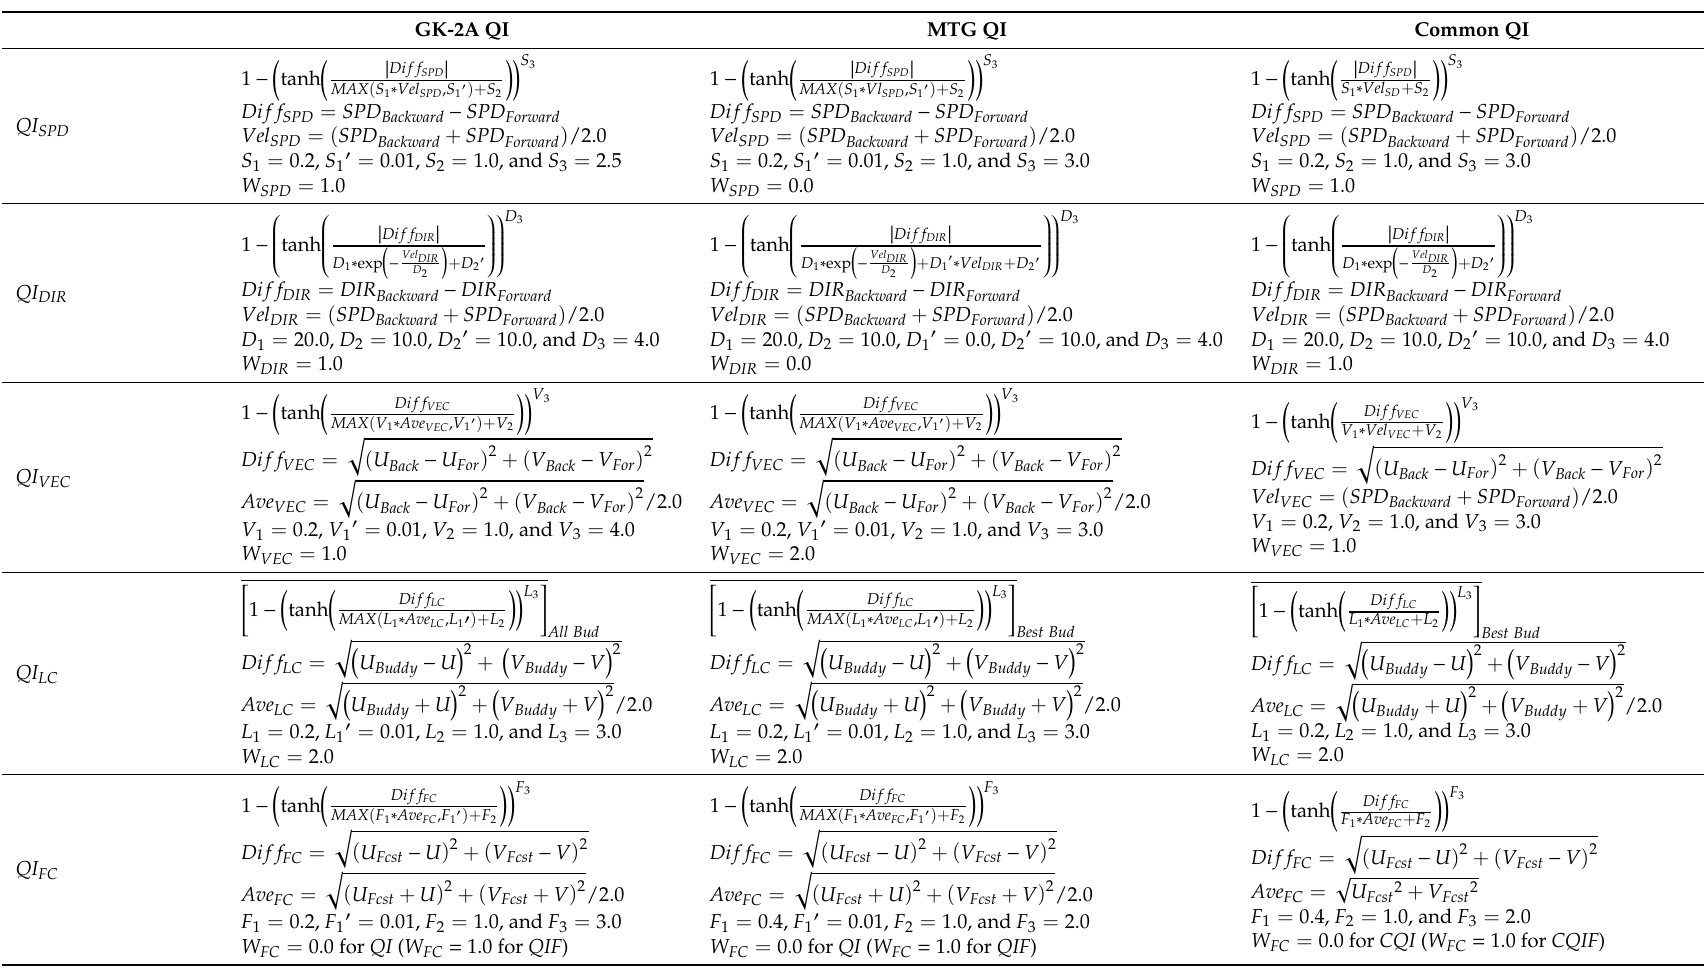
Table A2. Comparisons of GK-2A QI, MTG QI, and common QI. The final QI flags are the weighted averages of five components including speed consistency QI SPD , direction consistency QI DIR , and vector consistency QI VEC , first-guess consistency QI FC , and the spatial consistency QI LC in GK-2A and common QI algorithms. However, the weighted average of these five QI components, multiplied the additional height consistency, becomes the final QI value in MTG QI algorithm. GK-2A QI MTG QI Common